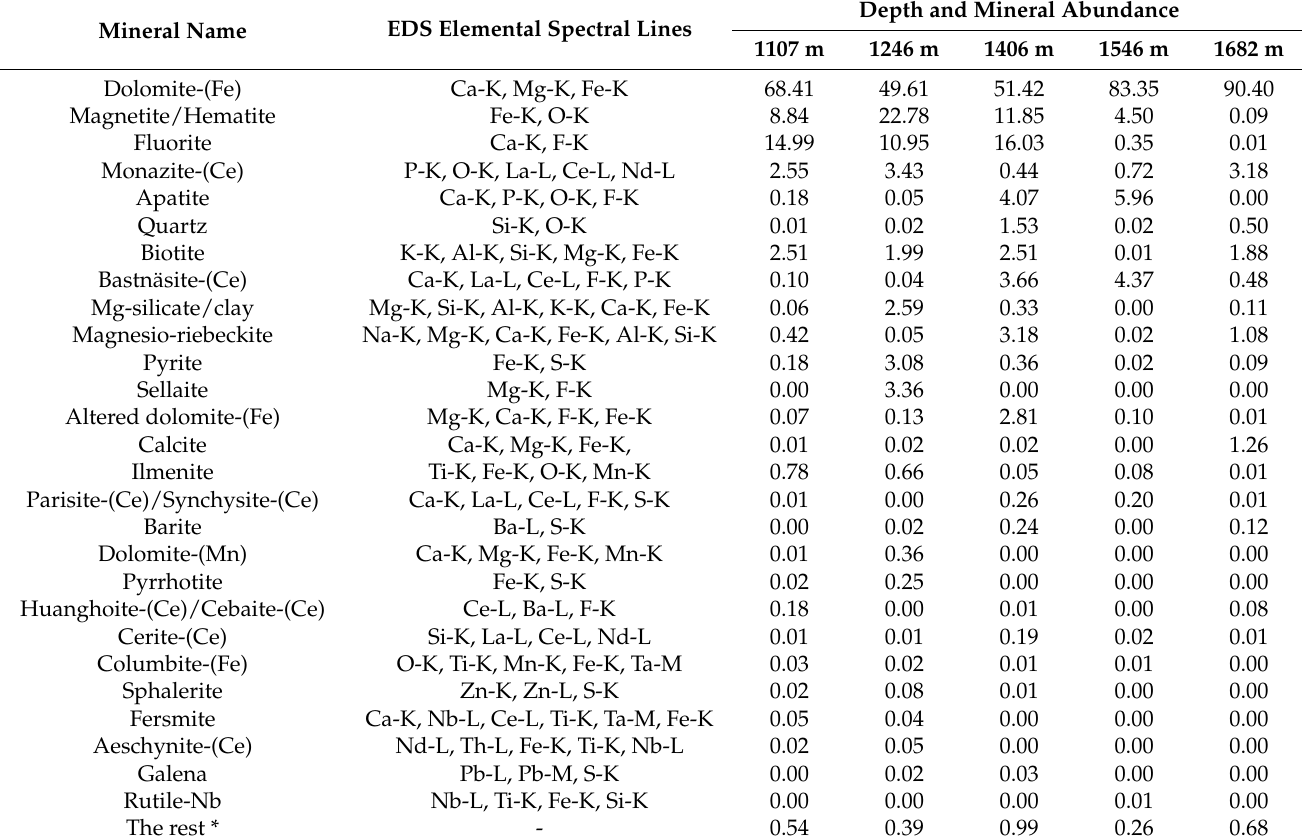
Table 1. Summary of the mineral abundance and EDS elemental spectral lines used for the Bayan Obo drill core samples from different depths given by TIMA analysis (in Vol.